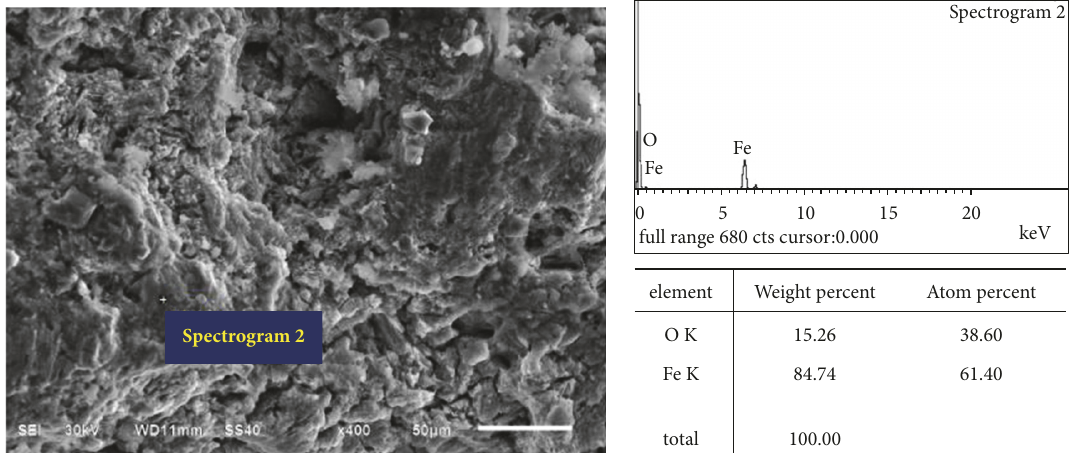
Figure 5: The oxides on the fracture of 4340 in 100 ∘ C oxygen-containing distilled water.